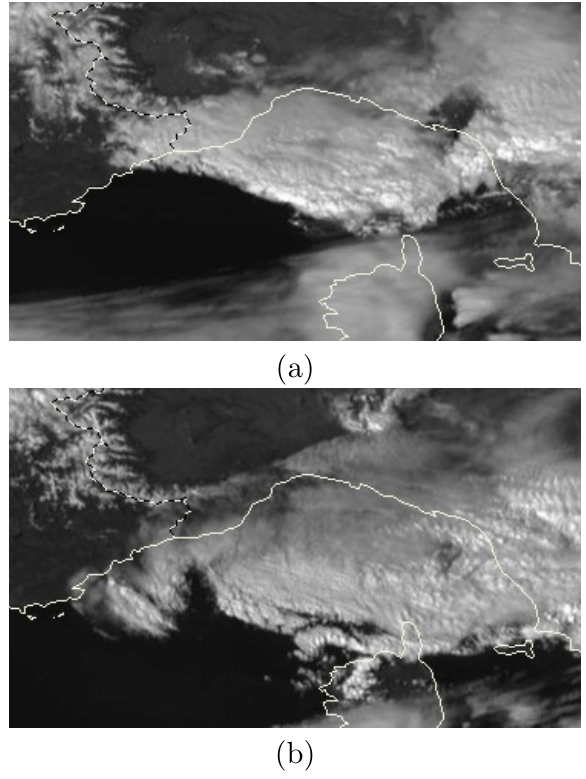
Fig. 3. Visible images from SEVIRI onboard Meteosat satellite for the 24 March 2009 at 12:30UTC (a) and 13:00 UTC (b)